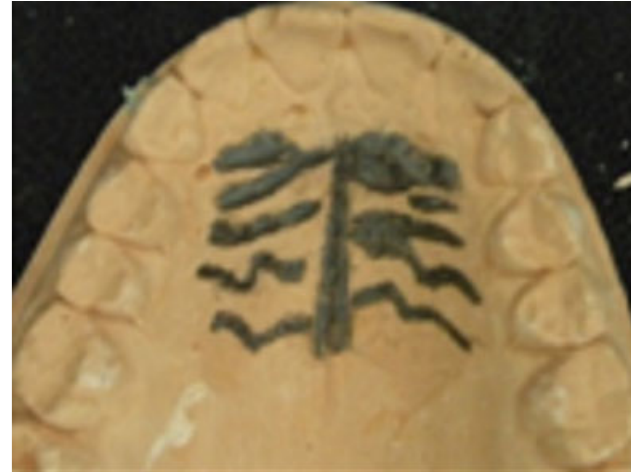
Fig. 3 - Cast with highlighted palatal rugae.